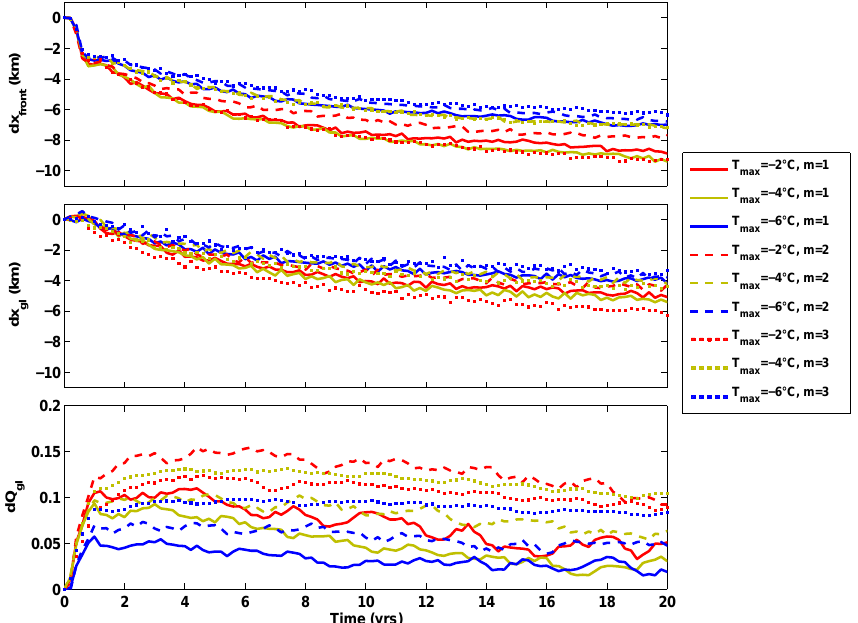
Fig. 7. Time series of (top panel) front position change, (middle panel) grounding line change, and (bottom panel) the fractional increase in grounding line discharge relative to the initial discharge for simulations performed using the seaward-dipping bed profile. As in Fig. 5, profiles are shown for the model simulations with enhanced ice deformation (i.e., E = 2).